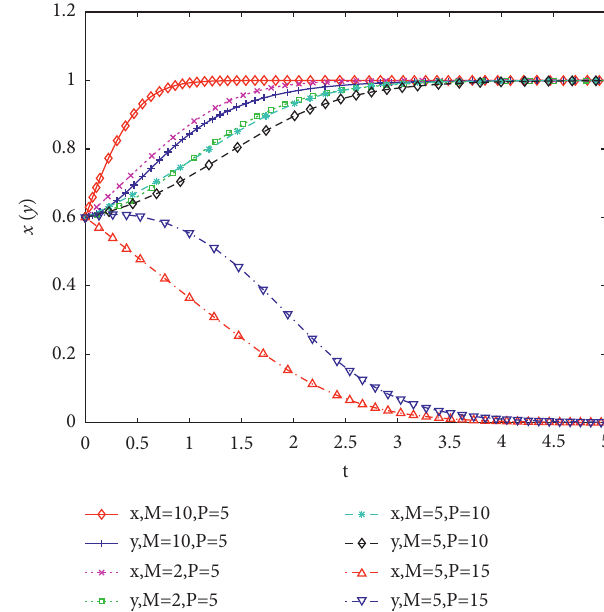
Figure 12: The stability analysis of Model II under different M and ps . P